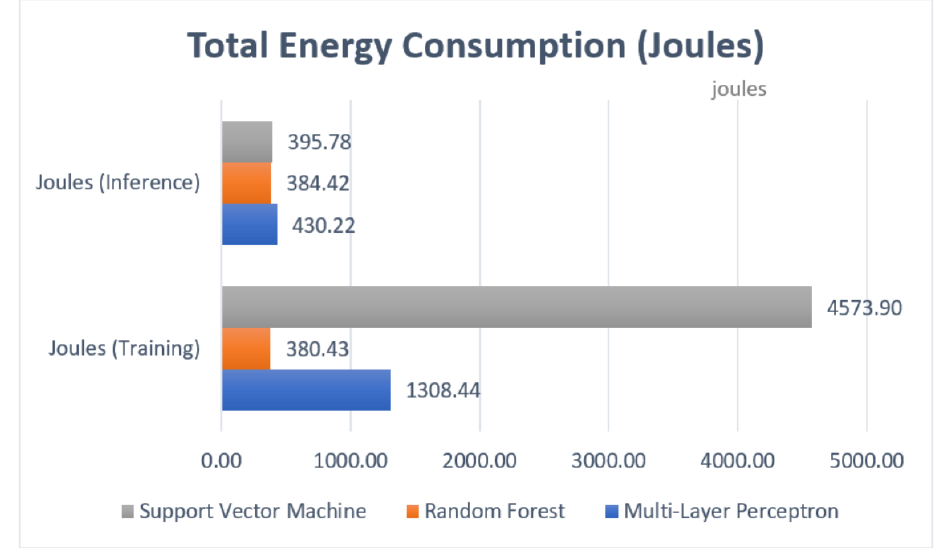
Figure 11. Algorithm total energy consumption